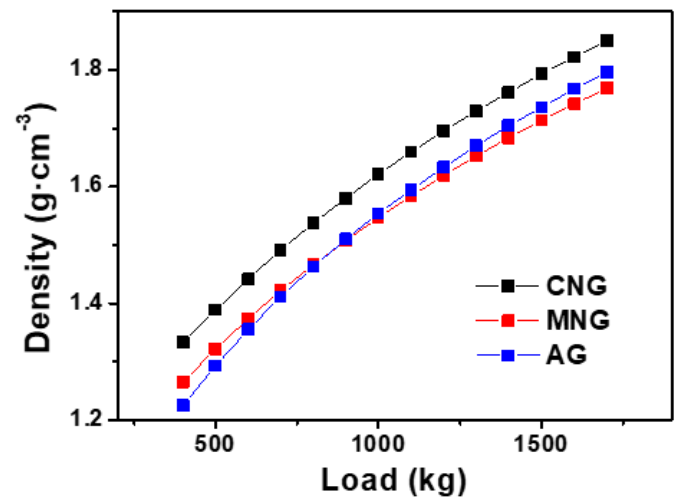
Figure 3. Compaction density of CNG, MNG, and AG samples.